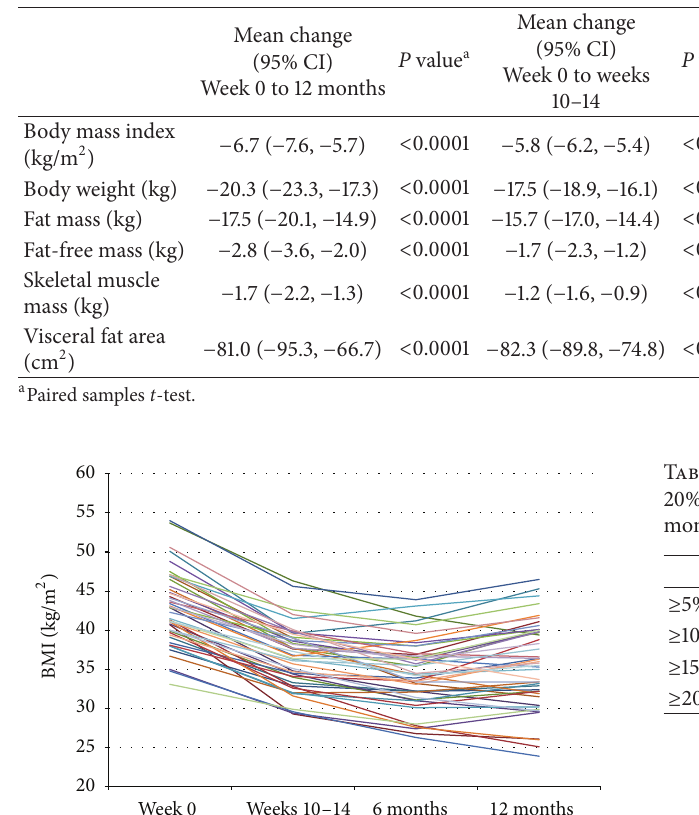
Table 3: Change in body composition from week 0 to 12 months within the ILI group (𝑛 = 71) .